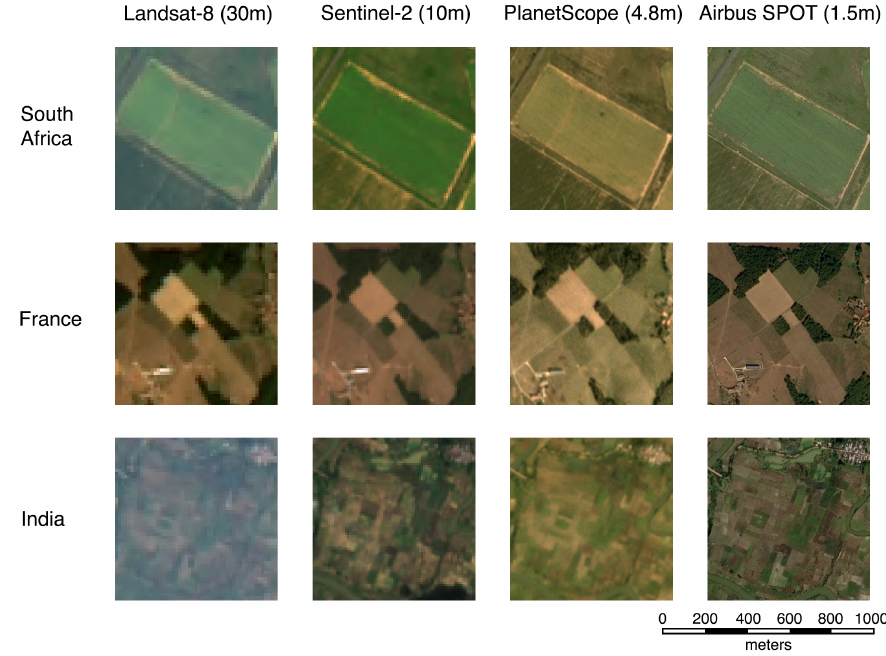
Figure 1. SatelliteimagestakenoveragriculturalareasinSouthAfrica, France, and India. From left to right, images are taken by Landsat-8 at 30 m resolution, Sentinel-2 at 10 m resolution, Planet’s PlanetScope at 4.8 m resolution, and Airbus SPOT at 1.5 m resolution. All images in South Africa were taken in February 2020, France in September 2019, and India in October 2020. As fields get smaller, higher resolution satellites are needed to delineate field